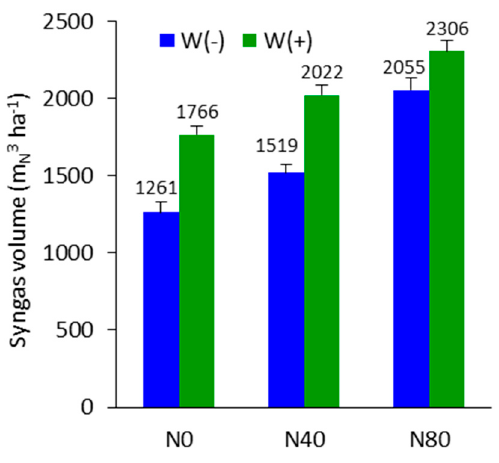
Figure 4. Volume of syngas obtained.